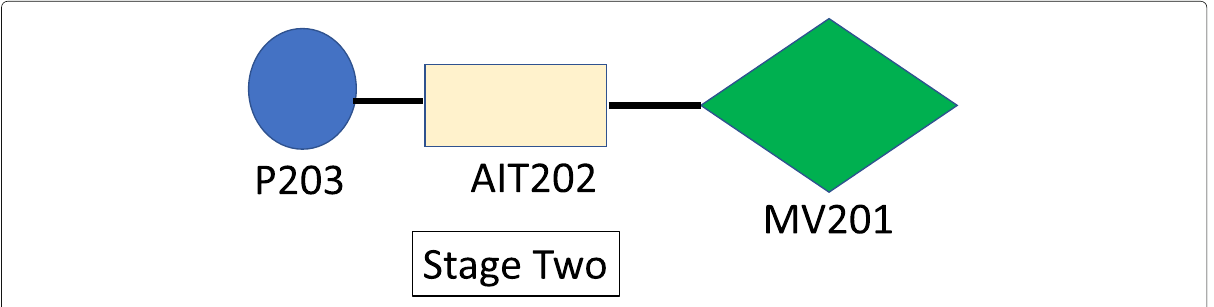
Fig. 9 Attacks #6 and #7 on SWaT: single attack, one